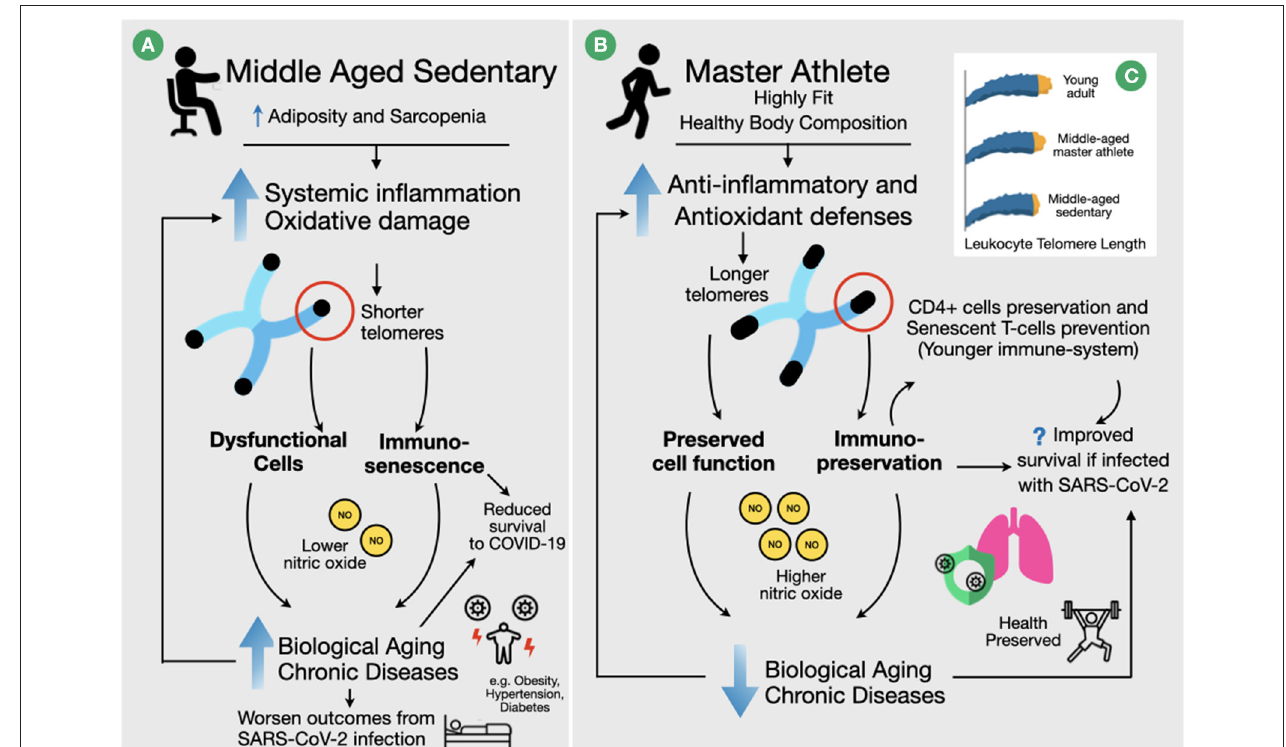
FIGURE 1 | Physical fitness and age-related biomarkers in regards to immune function, and possible outcomes in case of SARS-CoV-2 infection. (A) For sedentary person telomere length decreases during aging mainly due to associated chronic inflammation (“inflammaging”) and oxidative stress. Shorter telomere lengths lead to dysfunctional cells and immunosenescense that in turn contribute to a higher incidence of chronic diseases and immunosuppression. These conditions lead to a worsened prognosis in case of SARS-CoV-2 infection. (B) On the other hand, well-conditioned Master Athletes have a better anti-inflammatory profile and improved anti-oxidant defenses that are associated with longer leukocyte telomere lengths, preserved cellular function, immunosenescence prevention, and increased levels of nitric oxide compared to sedentary peers. These positive adaptations reduce the risk of developing chronic diseases and, if infected by SARSCoV-2, Master Athletes will possibly have a better outcome while facing COVID-19. (C) Illustrative representation of telomere length in leukocytes of young adults, middle-aged master athletes and sedentary peers. According to recent studies, the telomere length of master athletes is greater than that of age-matched sedentary, and may not differ from young adults, suggesting that master athletes are biologically younger than their chronological age (Simoes et al., 2017; Aguiar et al., 2019; Sousa et al.,